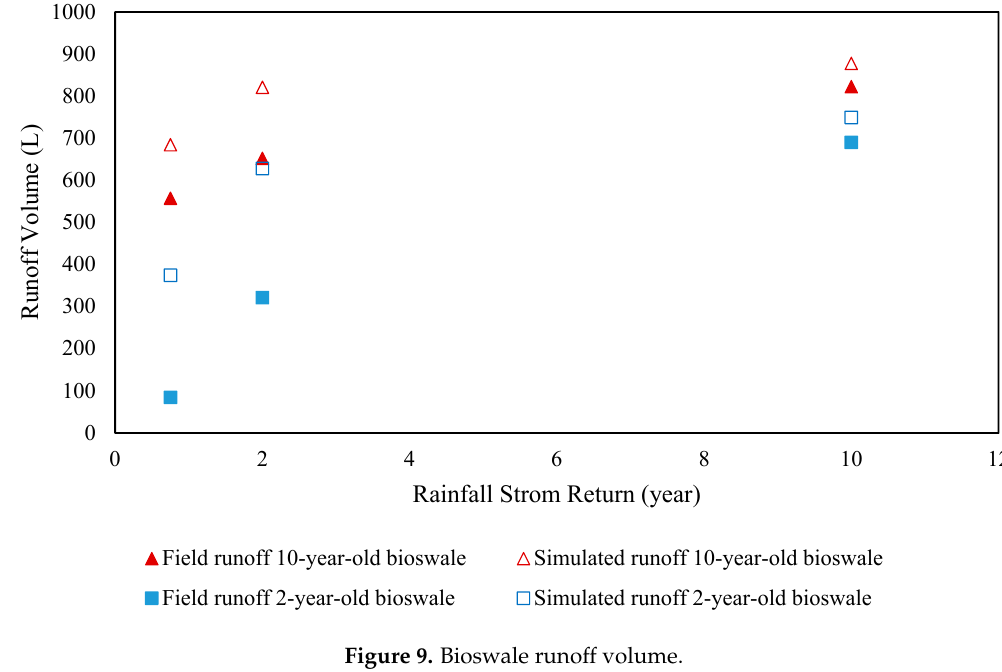
Figure 9. Bioswale runoff volume.